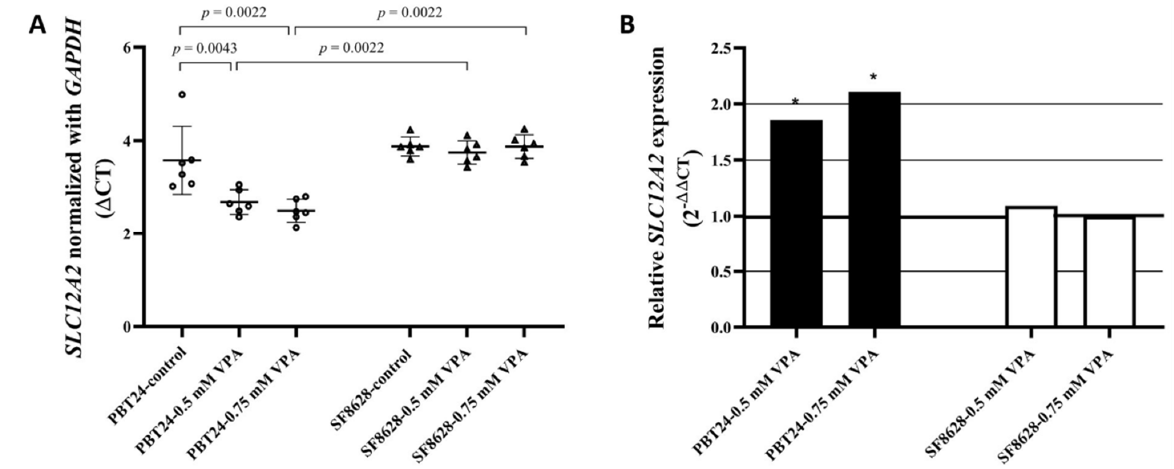
Figure 2. ( A ) SLC12A2 expression in PBT24 and SF8628 control groups and VPA-treated groups. Data are after normalization with GAPDH . Delta threshold cycle ( ∆ CT) values were used for the graph (the horizontal bars represent the mean; the short horizontal lines show standard deviation (SD) values). ( B ) SLC12A2 relative expression in PBT24 and SF8628 VPA-treated groups compared with respective control. The 1.0 line shows the starting point of gene expression; * p < 0.05. Compared to the PBT24 control, the 0.5 mM VPA dose increased SLC12A2 expression